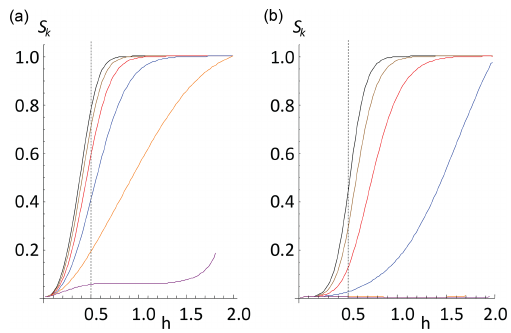
Figure 13. The 1-step (a) and 10-step (b) pure ( α = 0) fRn fore- cast skill as a function of h for various resolutions ( τ ) ranging from τ = 10 − 4 (black, left of each set) through τ = 10 − 3 (brown) 10 − 2 (red), 0.1 (blue), 1 (orange), and 10 (purple). In the right set τ = 1 (orange), 10 (purple) lines are nearly on top of the S k = 0 line. Again, red ( τ = 10 − 2 ) is the more empirically relevant value for monthly data. Recall that the regime h < 1 / 2 (to the left of the ver- tical dashed lines) corresponds to the overlap with